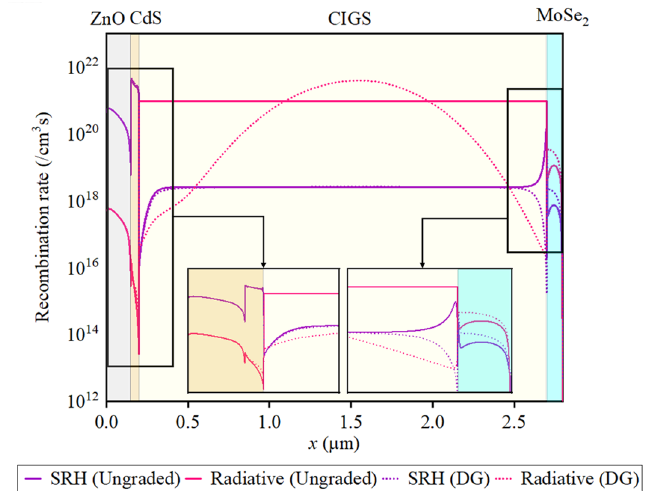
Figure 10. SRH and radiative recombination profiles at V = V OC (T = 300 K) under one sun illumination (AM 1.5) for the simulated CIGS cell with and without the presence of double grading (DG) bandgap alignment in the absorber layer. ( Left Inset ) Zoom-in image of the recombination rate curve at the interface of CdS/CIGS. ( Right Inset ) Zoom-in image of the recombination rate curve at the interface of CIGS/MoSe 2 .